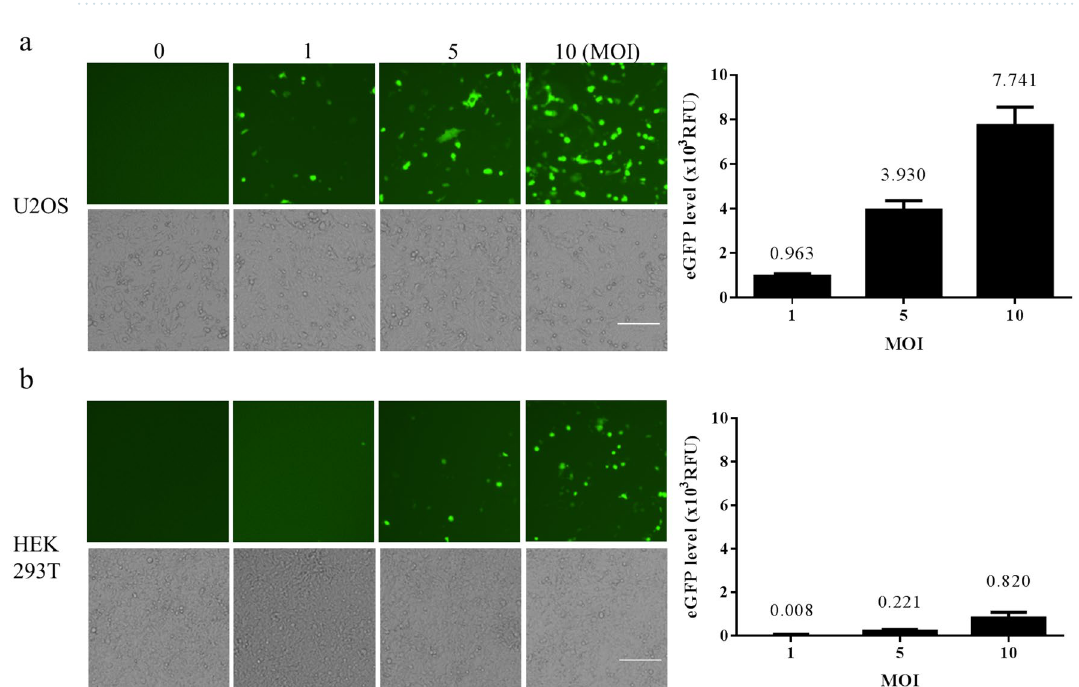
Figure 3. Autonomous CHIKV replicon-mediated expression of eGFP via baculovirus transduction in mammalian cell lines, U2OS ( a ) or HEK293T ( b ) cells via transduction with WT/eGFP at indicated MOIs of 0, 1, 5 or 10 in triplicate. At 2 dpt, eGFP-expressing cells were photographed using green (upper panels) or bright field (lower panels) filters. Expression levels of eGFP were quantified (right part). Error bars represent the standard